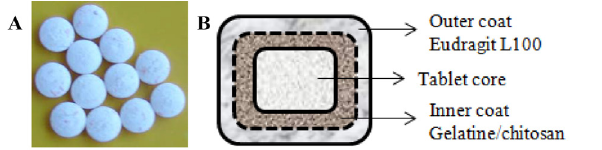
FIGURE 1 - Bilayer coated tablet. Bilayer coated tablet was prepared in this study (A); shematic of the bilayer coated tablet delivery system (not to scale)